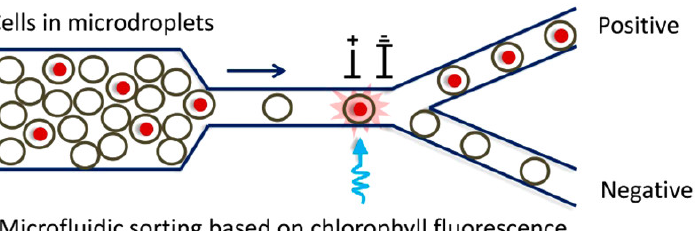
Figure 10. Schematic depiction of the fluorescence-based sorting method. Reprinted with permission from [119]. Copyright 2016,